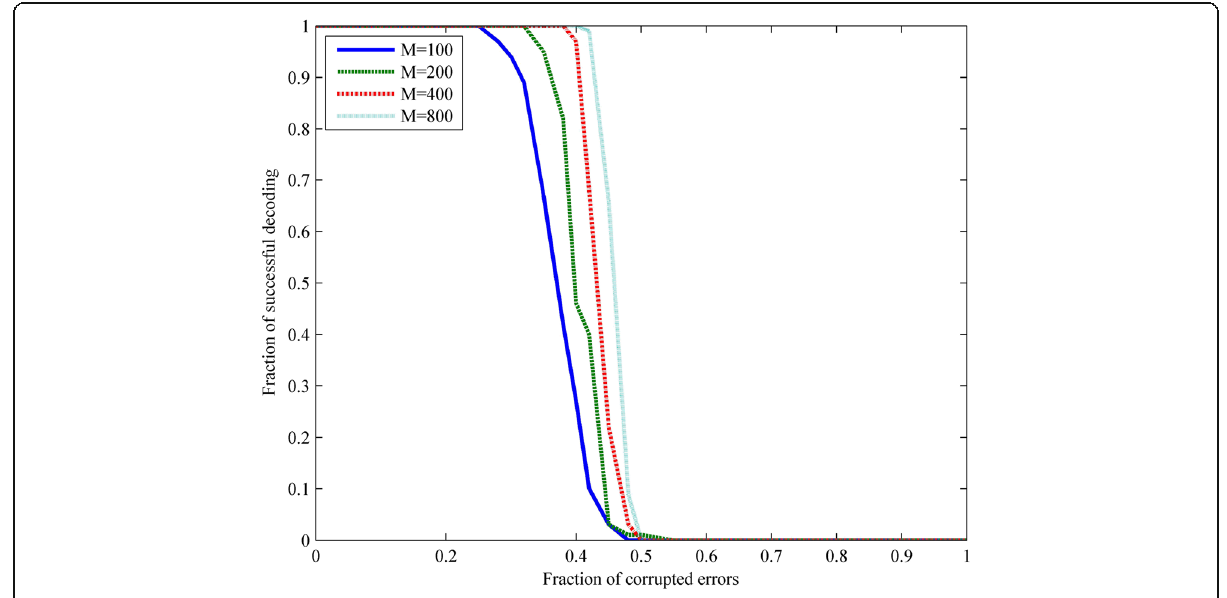
Fig. 4 Error correction in L1 optimization when ‖ x 0 ‖ = m 1/2 . Legend ( ‘ M = 8 ’ , ‘ M = 20 ’ , ‘ M = 40 ’ , ‘ M = 60 ’ , ‘ M = 80 ’ )